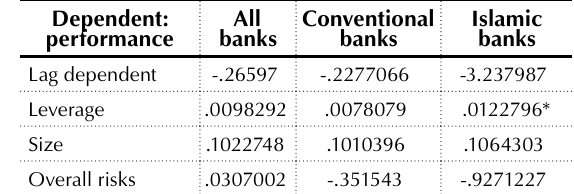
Table 9. Levels of corporate risk disclosure of